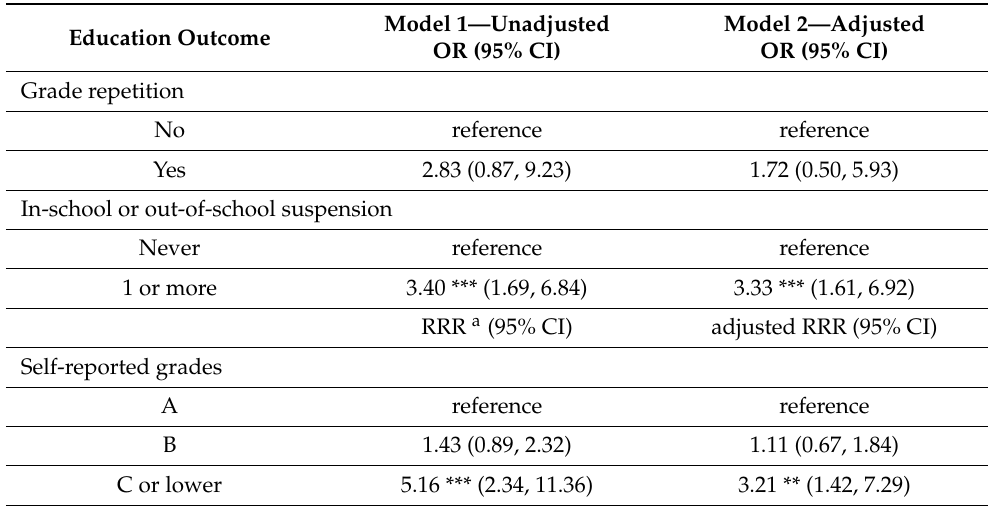
Table 2. Odds or relative risk of poor education outcomes for adolescents with at least one ACE compared to those with no ACEs (n =